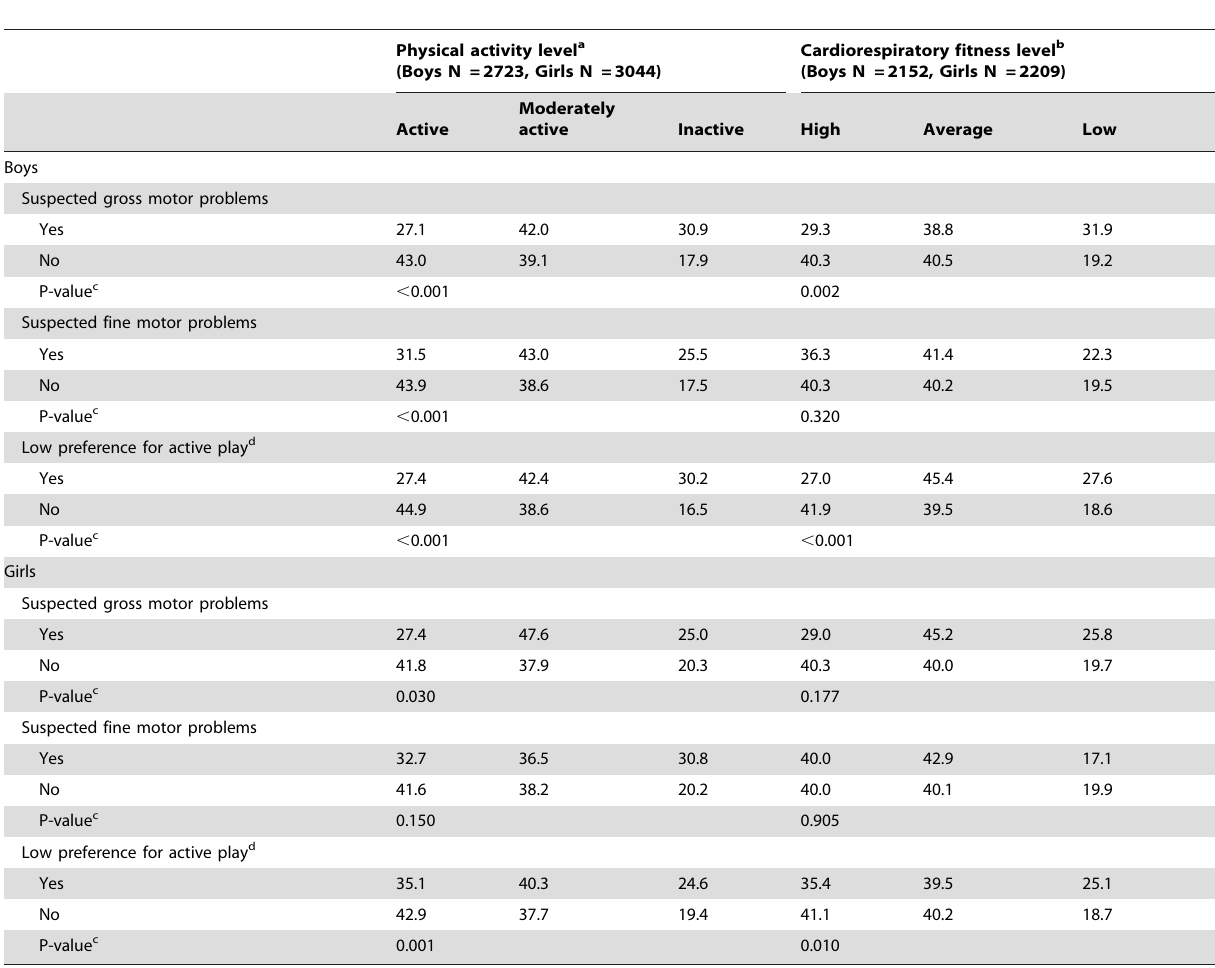
Table 2. The level of physical activity and cardiorespiratory fitness at age 16 years by suspected motor problems and low preference for active play at age 8 years.